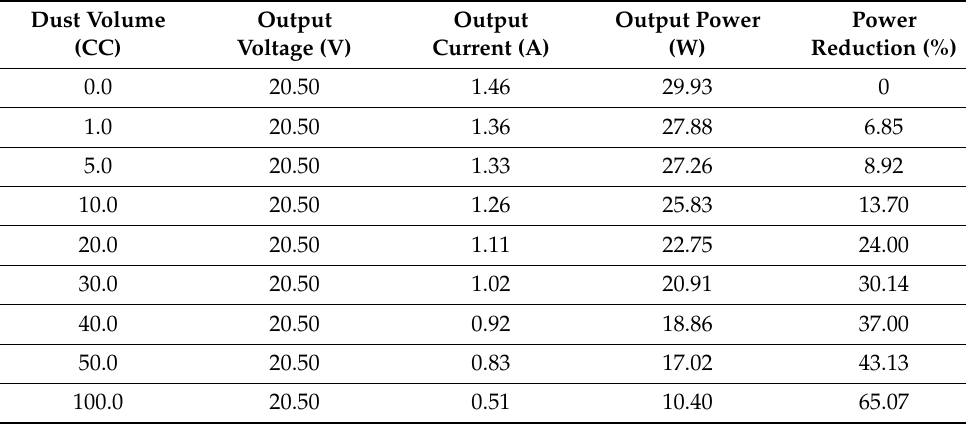
Table 2. Effect of dust on solar panel power